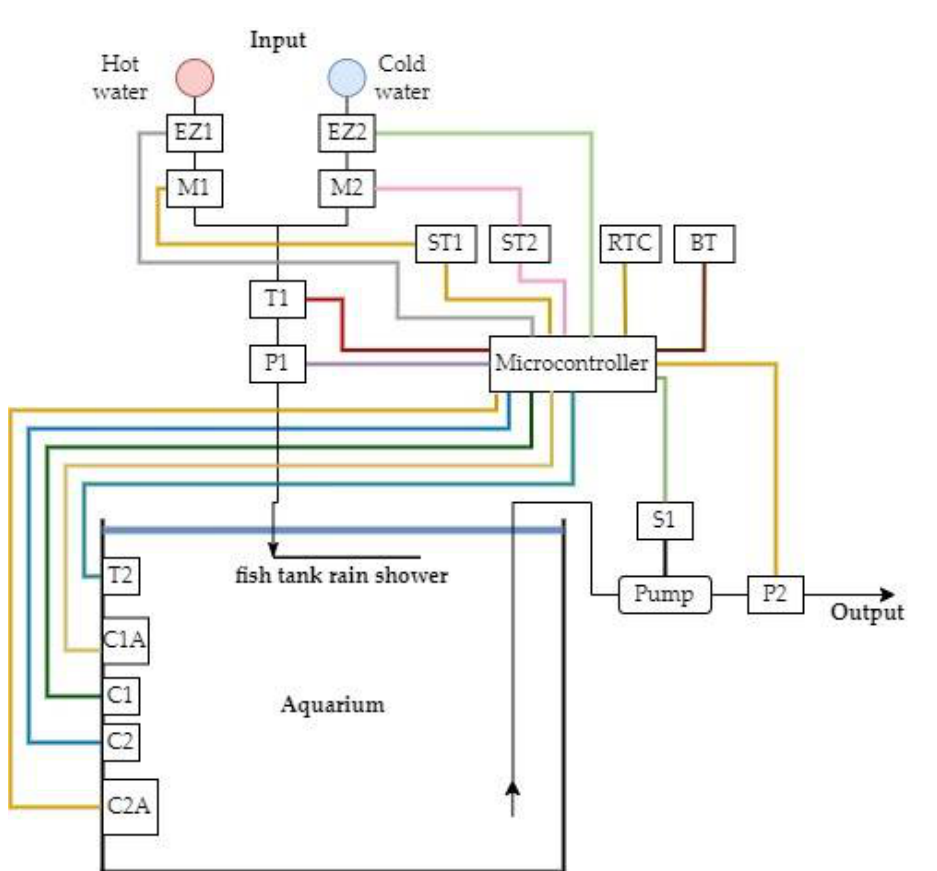
Figure 1. Schematic diagram of the AWES. C1, C2—float liquid level sensors; C1A, C2A—emergency